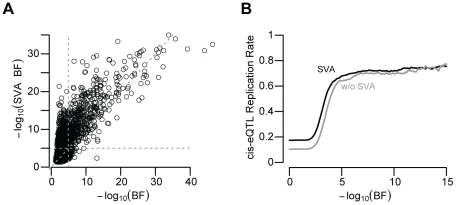
SVA improves eQTL reproducibility.(A) Surrogate variable regression produces more significant associations.
Each point represents the BF for each UC gene expression trait and its
best associated SNP. Data are plotted for associations tested after
surrogate variable regression (y-axis) and unadjusted for surrogate
variables (x-axis). Note that most points fall above the diagonal,
indicating increased eQTL significance after surrogate variable
correction. (B) Cis-eQTL replication rate (y-axis; UC vs UW or Merck) as
a function of UC BF threshold. SVA adjusted associations depicted in
black, unadjusted in grey.